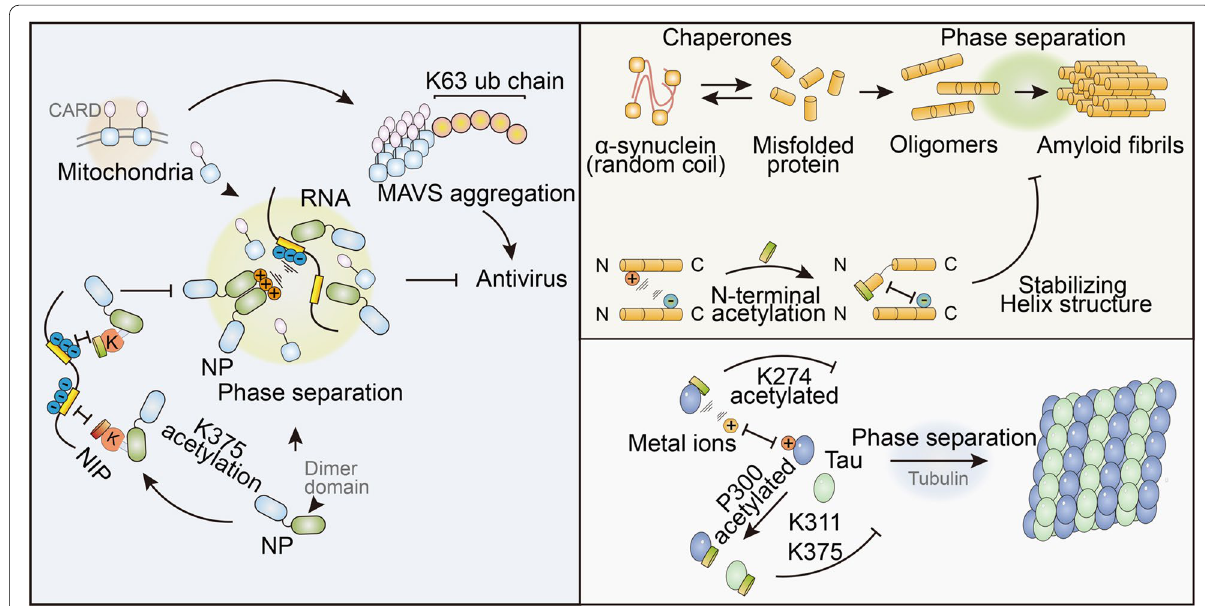
Fig. 6 Acetylation in SYN and Tau phase separation. Naive SYN is misfolded and aggregated into oligomers, with the help of molecular chaperones. LLPS is crucial for the formation of amyloid fibrils formation and subsequent neurodegenerative diseases. N-terminal acetylation inhibits SYN from LLPS by neutralizing the positively charged N-terminal and stabilizing the Helix structure. Acetylation on K274 and K311/375 in Tau is also found to be inhibitory for its LLPS, either by enhancing ion binding affinity or hindering